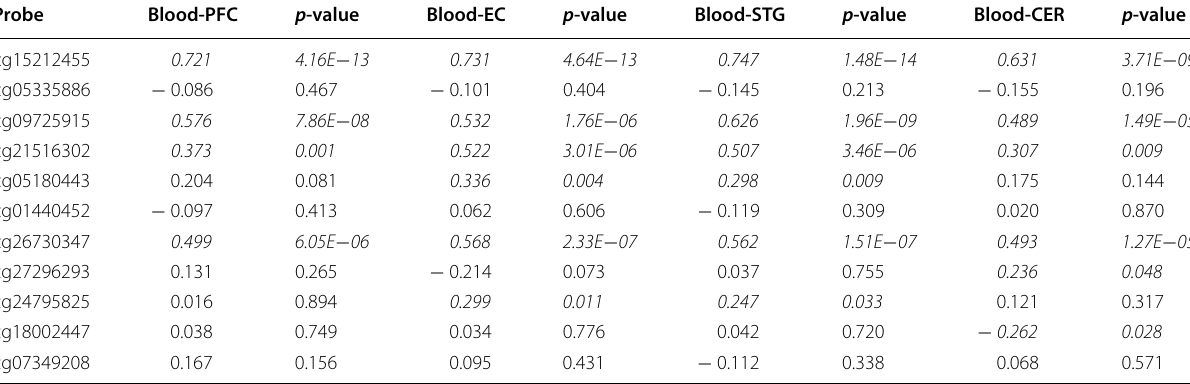
PFC prefrontal cortex, EC entorhinal cortex, STG superior temporal gyrus, CER cerebellum Significant correlations in italics